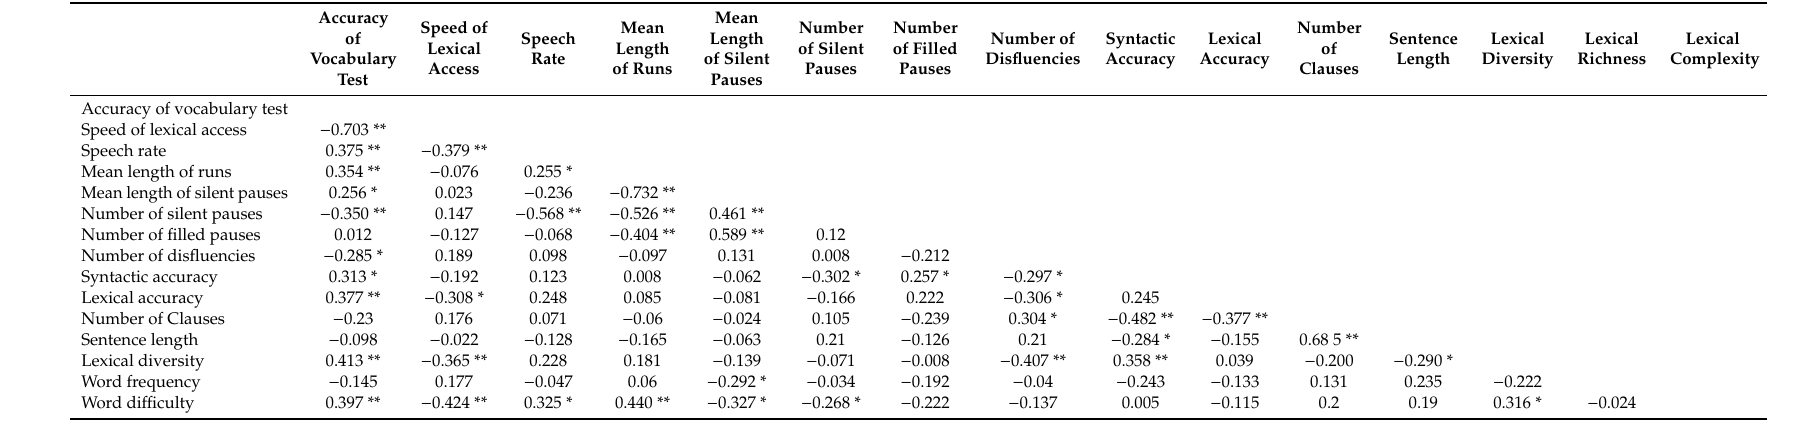
Syntactic Accuracy